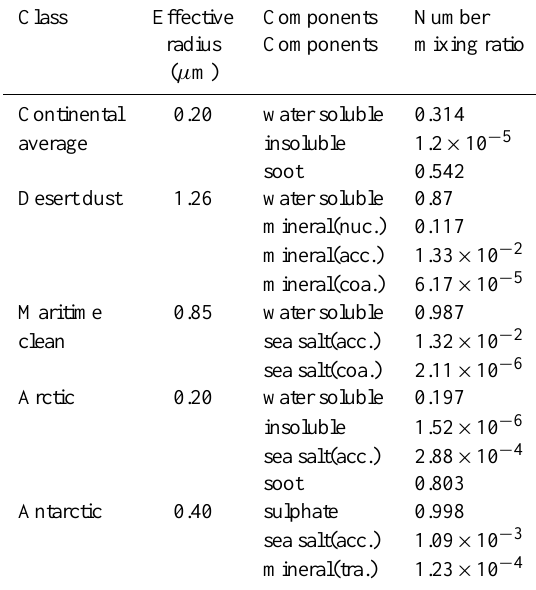
Table 1. Properties of the aerosol types used in the GRAPE aerosol product (taken from Hess et al., 1998). The abbreviations nuc., acc. and coa. refer to the nucleation, accumulation and coarse modes, while tra. is short for transported. Note that the listed effective radius defines the a priori effective radius in the retrieval. In the retrieval this is varied by altering the number mixing ratio of the components which make up the